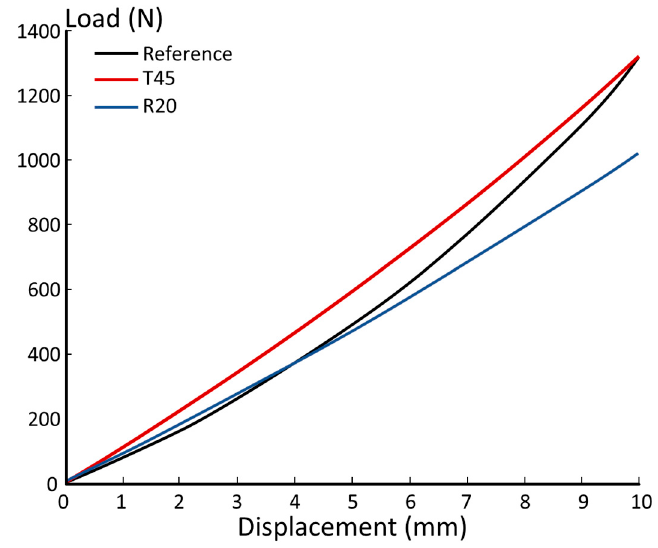
Figure 12. Load–displacement curves from the FE